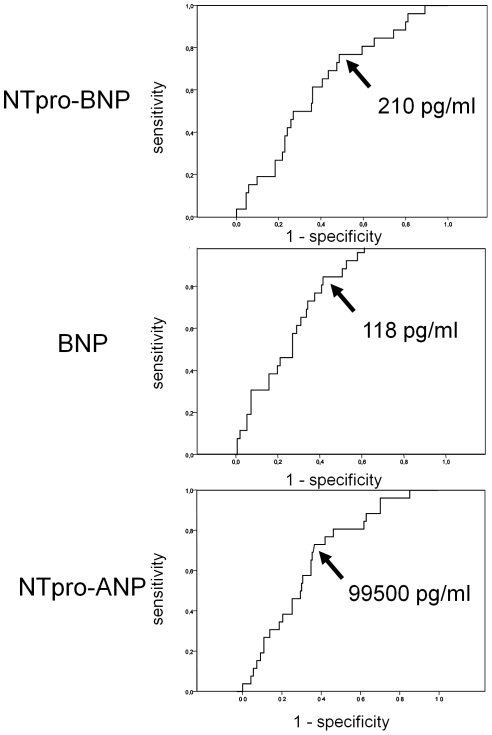
Diagnostic properties of natriuretic peptide levels for detecting paroxysmal atrial fibrillation.Upper panel: Receiver operating characteristic curve for NT-proBNP plasma levels in the detection of paroxysmal atrial fibrillation. The arrow indicates the Youden-point, which was a NT-proBNP plasma level of 210 pg/ml. Middle panel: Receiver operating characteristic curve for BNP plasma levels in the detection of paroxysmal atrial fibrillation. The arrow indicates the Youden-point, which was a BNP plasma level of 118 pg/ml. Lower panel: Receiver operating characteristic curve for NT-proANP plasma levels in the detection of paroxysmal atrial fibrillation. The arrow indicates the Youden-point, which was a NT-proANP plasma level of 99,500 pg/ml.